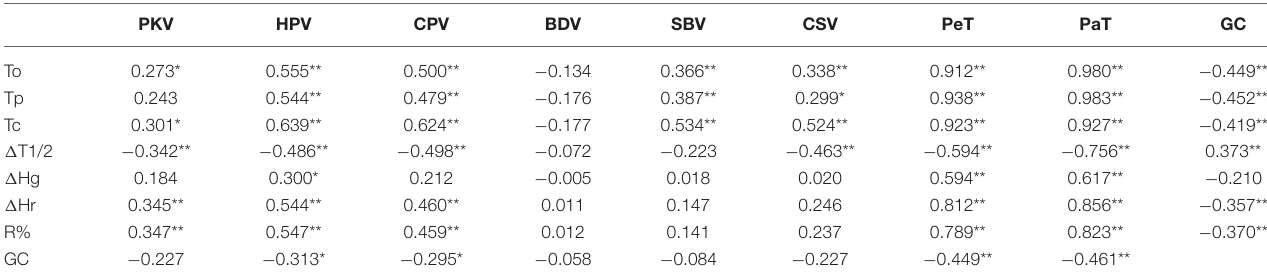
TABLE 2 | Correlations among PVP, thermal and RP, and GC.